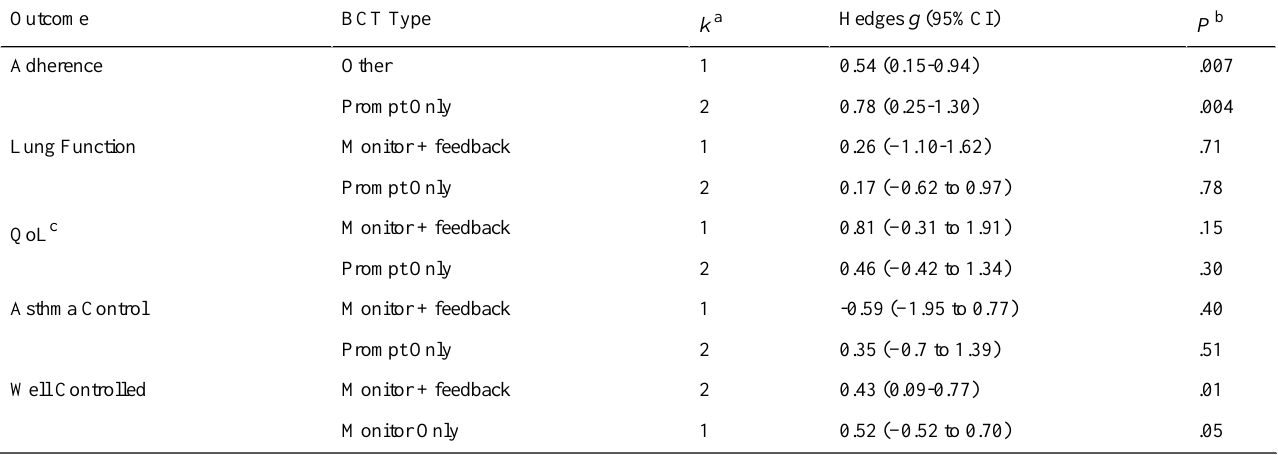
Table 6. Categorical moderation analysis for within group behavior change technique (BCT) type on relationship between mobile technology intervention, adherence, and clinical